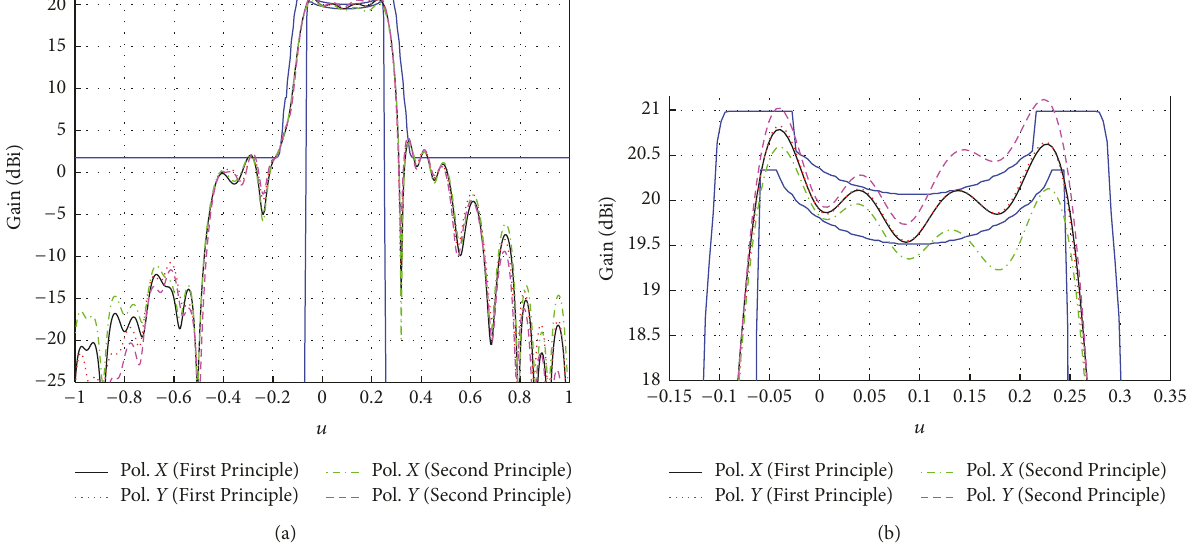
using the POS formulation of the First Principle. (a) Main cut in 𝑢 . (b) Zoom on the coverage area.